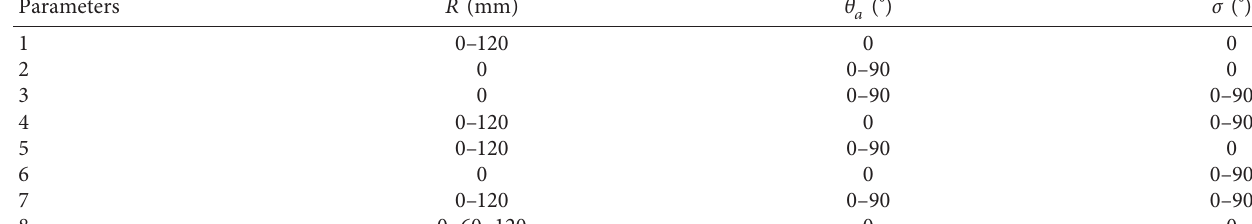
Table 2: Parameter value of balance